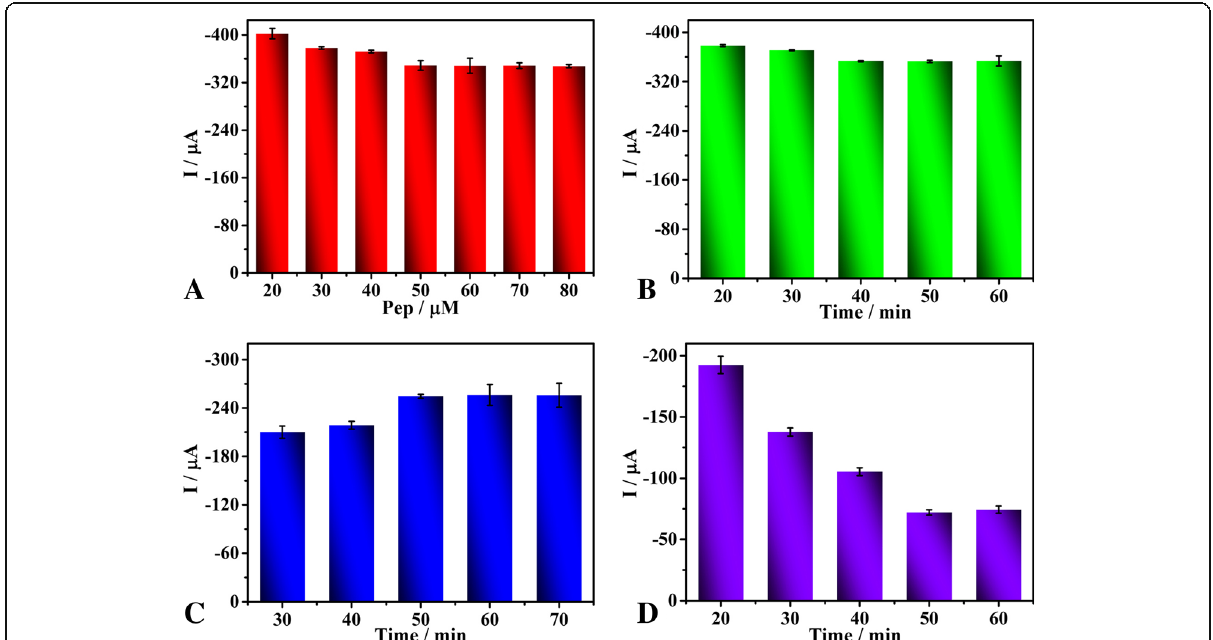
Fig. 5 Effects of peptide concentration ( a ), incubation time of 50 μ M peptide ( b ), peptide cleavage time ( c ) and precipitation reaction time ( d ) on the current responses of the biosensor